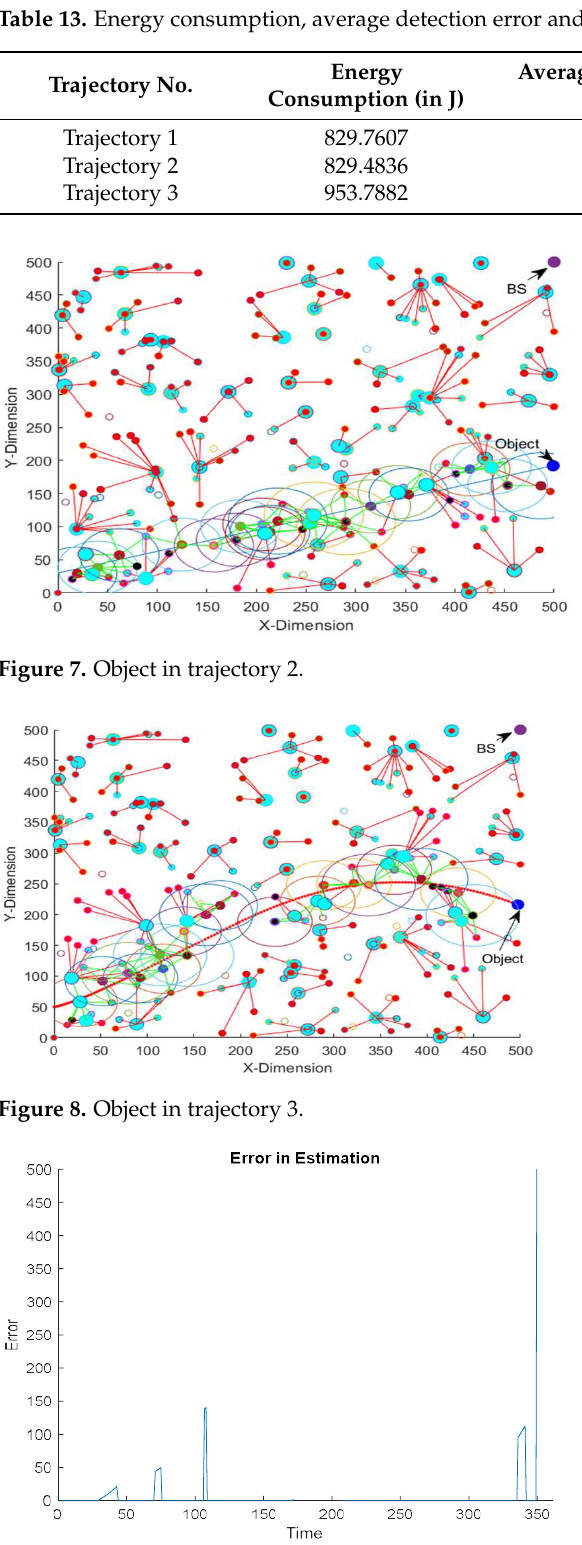
Figure 9. Object localization error in EEODTF for trajectory 1.